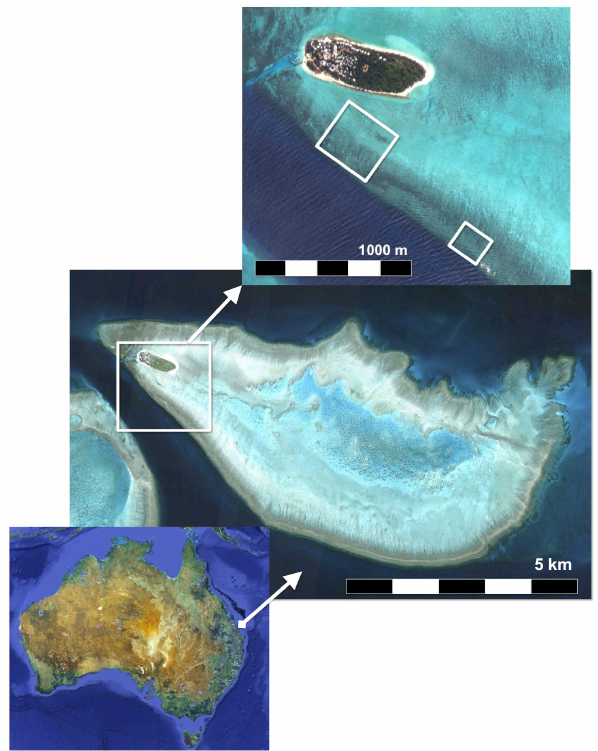
Fig. 2. Study areas on Heron Reef, Southern Great Barrier Reef, Australia. All benthic groups except crustose coralline algae (CCAs) were collected from across the 500m reef flat within the large area (top insert). CCAs were collected from within the small